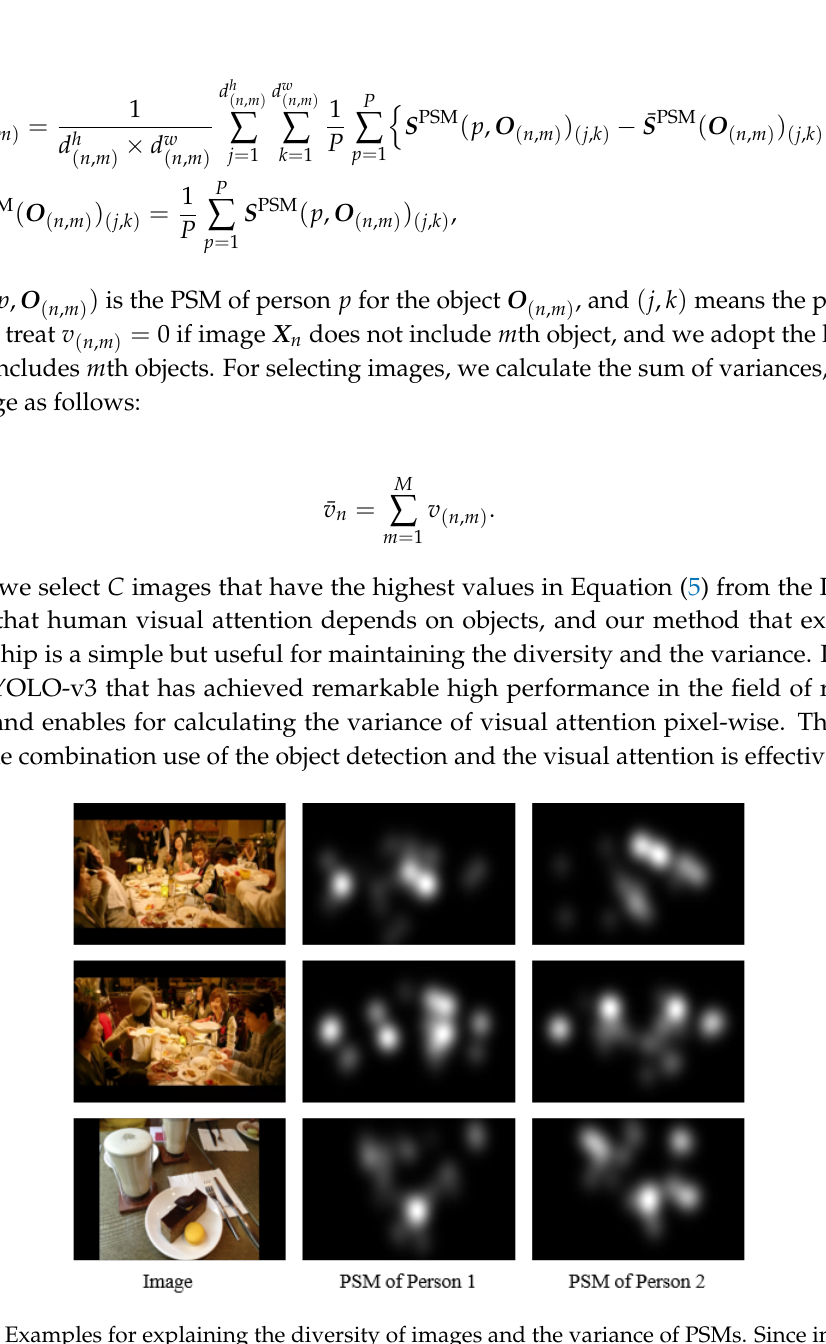
Figure 4. Examples for explaining the diversity of images and the variance of PSMs. Since images in the first and second rows are visually similar, AIS selects either one. On the other hand, for the image in the third row, since PSMs of person 1 and person 2 are similar, AIS does not select this